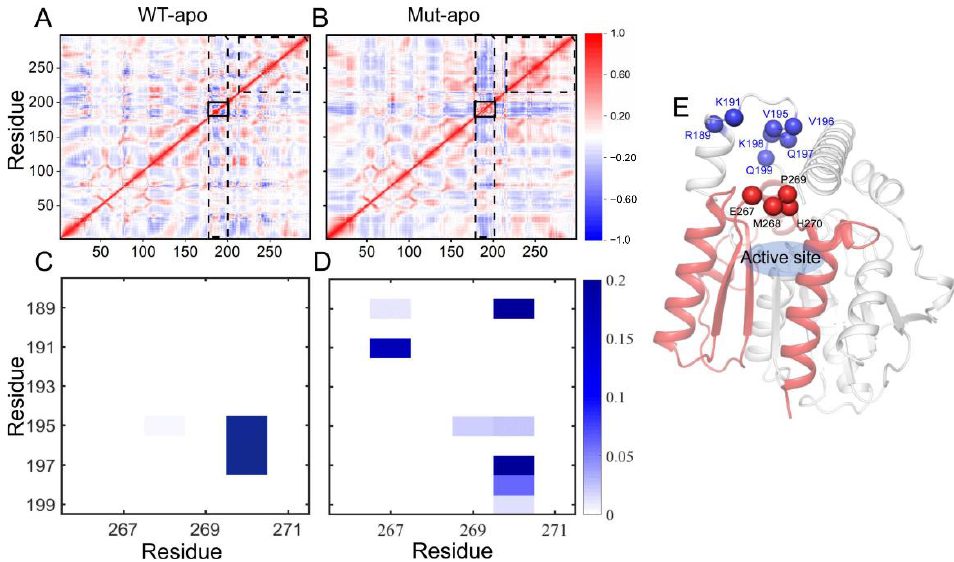
Figure 4. The residue–residue correlation information of the entire protein and the contact information of the pocket entrance regions in the two apo systems. ( A , B ) Dynamical cross-correlation maps for the C α atom pairs according to the last 100-ns MD trajectories: WT-apo ( A ) and Mut-apo ( B ). Areas with strong variations between apo systems are emphasized with black boxes. ( C , D ) The contact map between the lid region and residues 265–272: WT-apo ( C ) and Mut-apo ( D ). ( E ) The overall structure of EstJ6. The pocket entrance residues are indicated by blue and red spheres, and residues 200–297 are depicted in red.